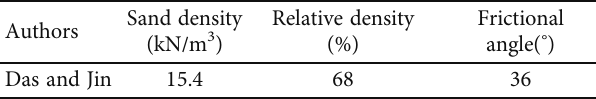
Table 5: Group anchor con fi gurations.